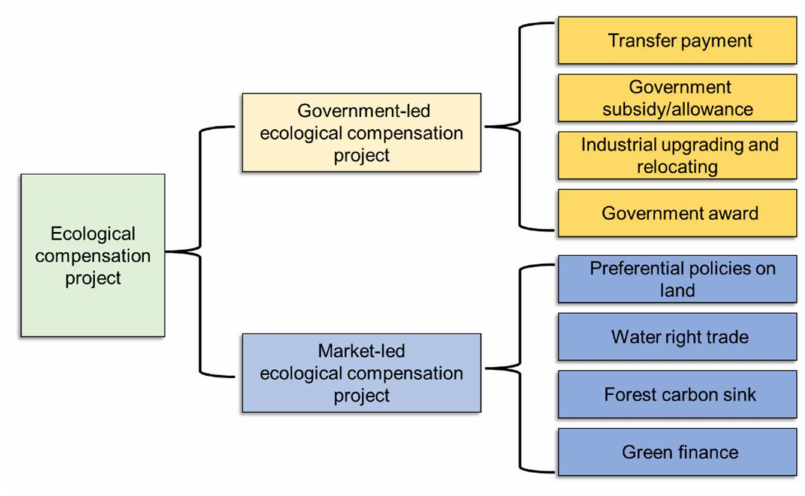
Figure 1. China’s ecological compensation